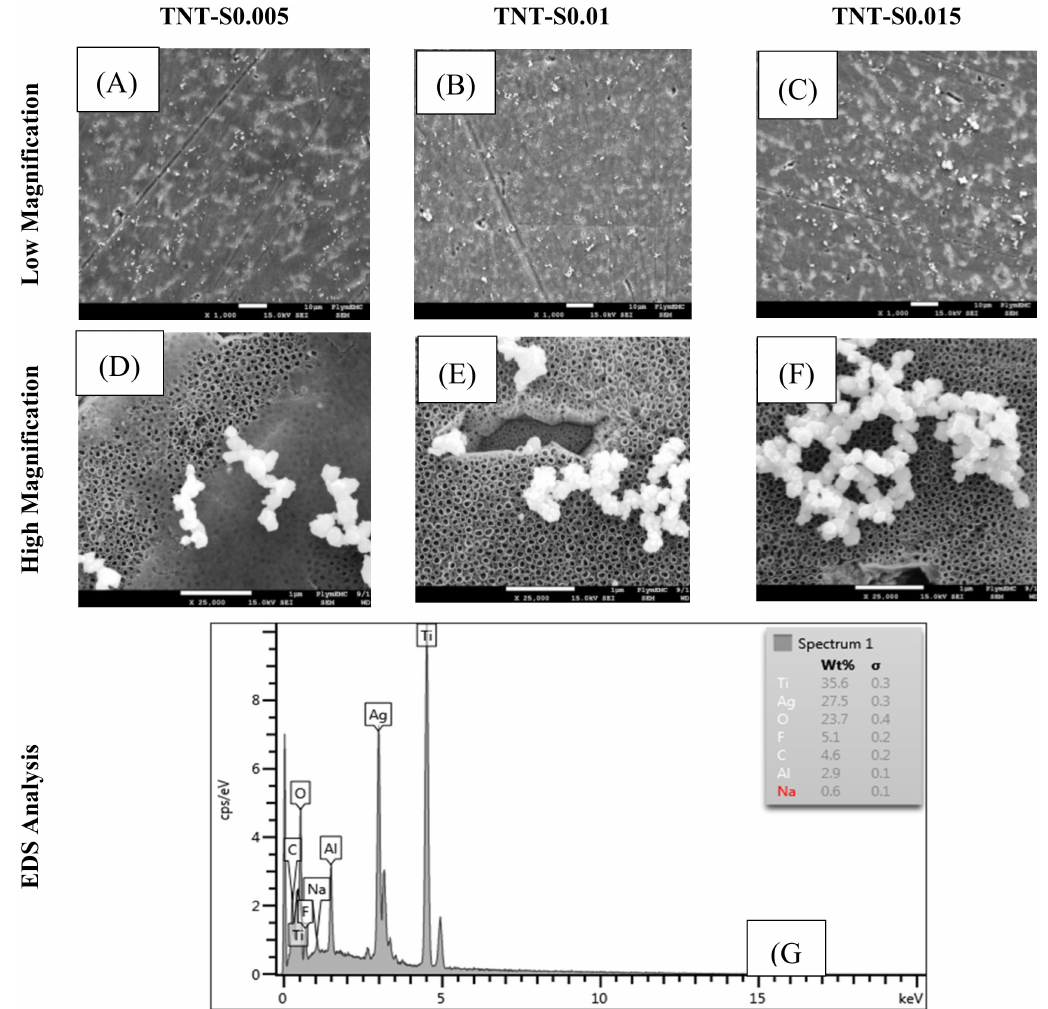
Figure 6. SEM images of silver nanoparticles forming micro-clusters on titanium dioxide nanotubes, TNT grown using ( A ) 0.005 M, ( B ) 0.01 M and ( C ) 0.015 M of silver ammonia solution and 0.002 M δ -gluconolactone as a mixture at low magnification. ( D – F ) show the higher magnification of (A), (B) and (C). ( G ) EDS analysis of the silver nanoparticles grown on TNT, showing the distribution of the di ff erent components on the surface. (Reproduced with permission from Gunputh et al., Anodised TiO2 nanotubes as a sca ff old for antibacterial silver nanoparticles on titanium implants; published by Elsevier, 2018,